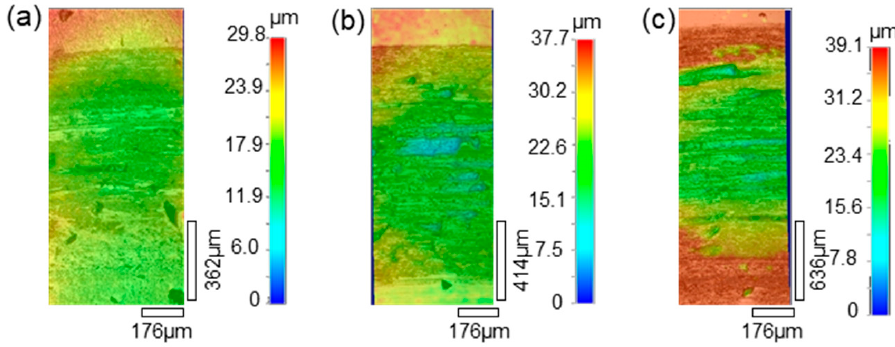
Figure 13. EDS patterns of the wear surface of the ( a ) 27CrMoV substrate and ( b ) WC–10Co4Cr coatings after friction test at different loads.